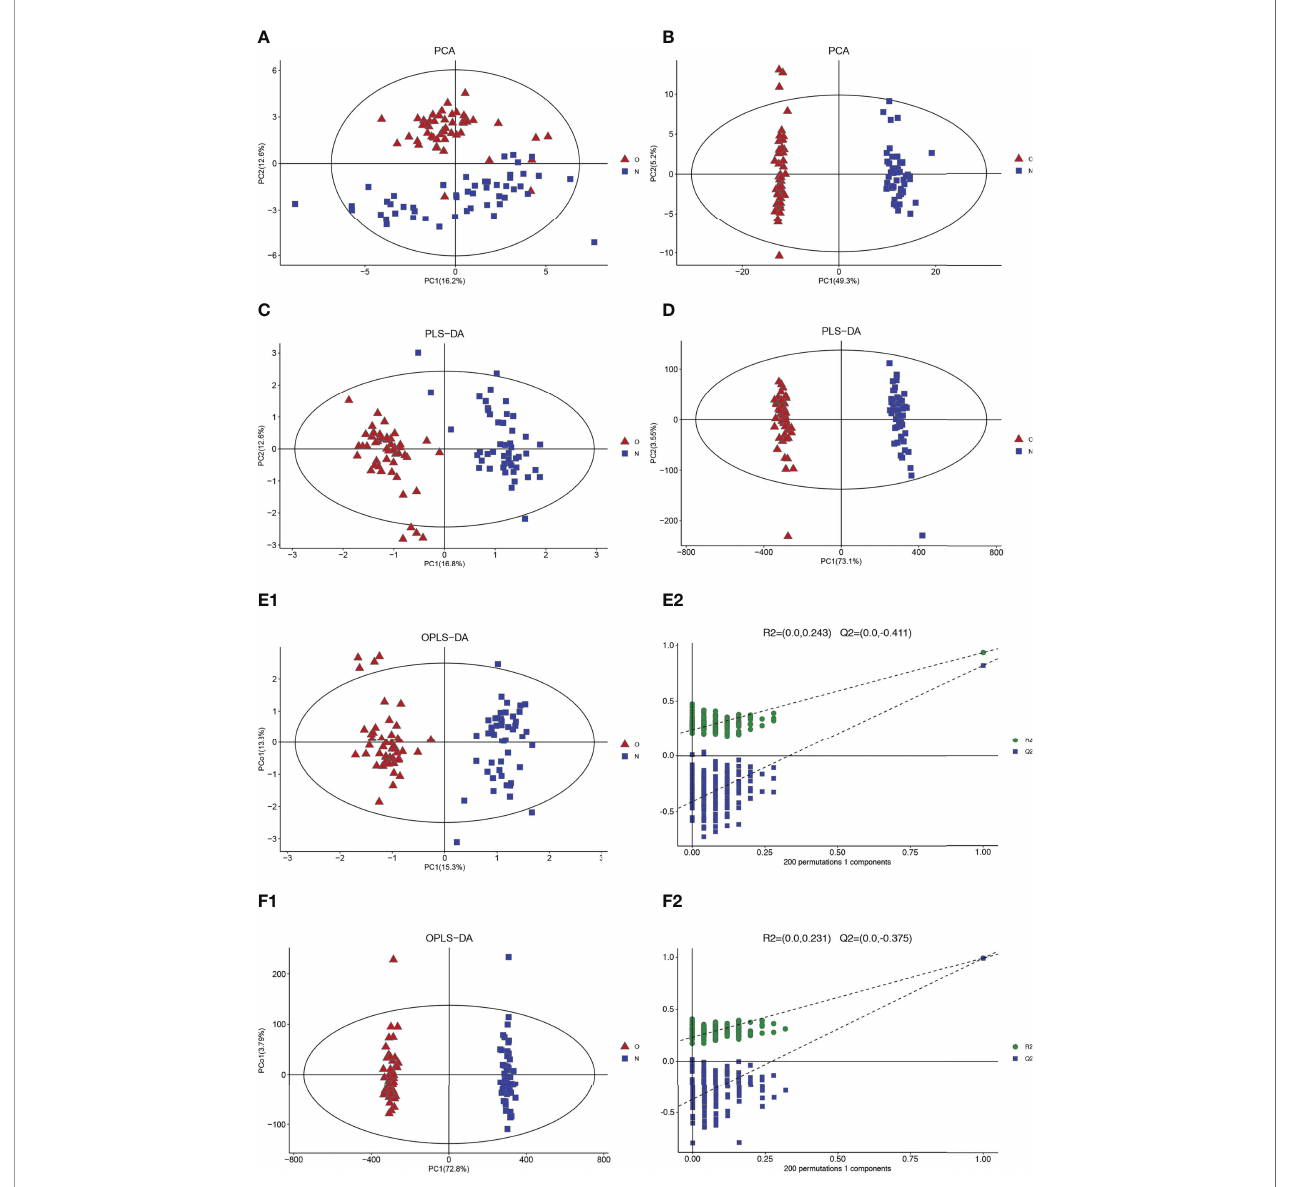
FIGURE 1 | Multivariate date analysis of date from serum between the case group (O red triangle) and healthy control group (N blue squares) base on GC/LC-MS. (A) PCA score plots based on the GC-MS. (B) PCA score plots based on the LC-MS. (C) PLS-DA score plots. (D) PLS-DA score plots. (E1, 2) OPLS-DA score plots (left panel) and statistical validation of the corresponding OPLS-DA model by permutation analysis (right panel) based on the GC-MS. (F1, 2) OPLS-DA score plots (left panel) and statistical validation of the corresponding OPLS-DA model by permutation analysis (right panel) based on the LC-MS. The two coordinate points are relatively far away on the score map, indicating that there is a signi fi cant difference between the two samples, and vice versa. The elliptical region represents a 95% con fi dence